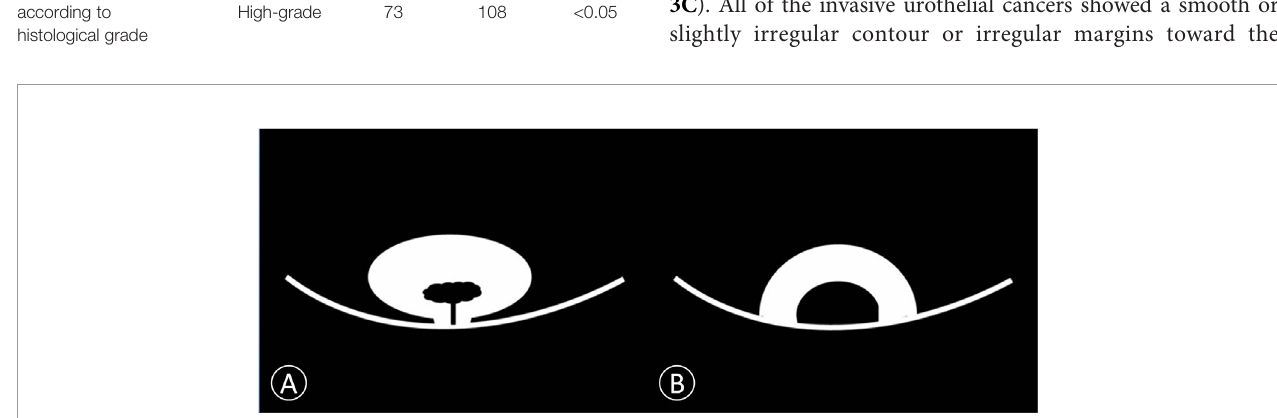
FIGURE 2 | Schematic diagram of non-invasive bladder cancer. (A) Cancer is connected to the bladder wall by a thin pedicle with a small contact area. We proposed this model as papillary cancer that could be observed on DWI. (B) Cancer is connected to the bladder wall with a wide base contact area. We proposed this model as sessile cancer that could be observed on